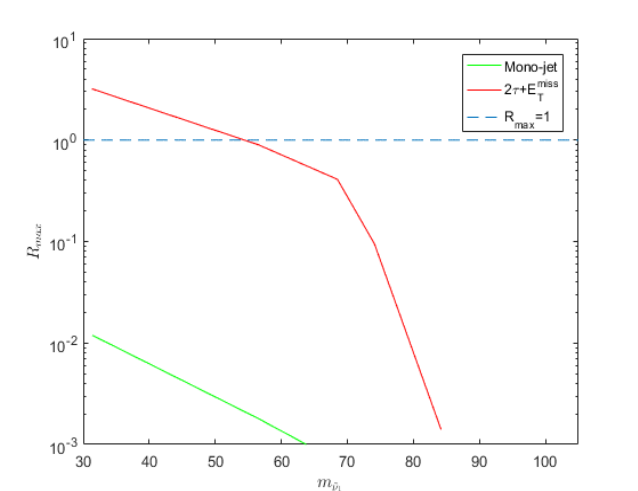
Figure 7 . R max as a function of m ~ (cid:23) (red line). Note that in this work, the higgsino mass is (cid:12)xed at 120 GeV, and consequently m 121 : 9 GeV, (cid:27) 8TeV ( pp ! ~ (cid:31) (cid:6) sections are calculated at next-to-leading order by the code Prospino